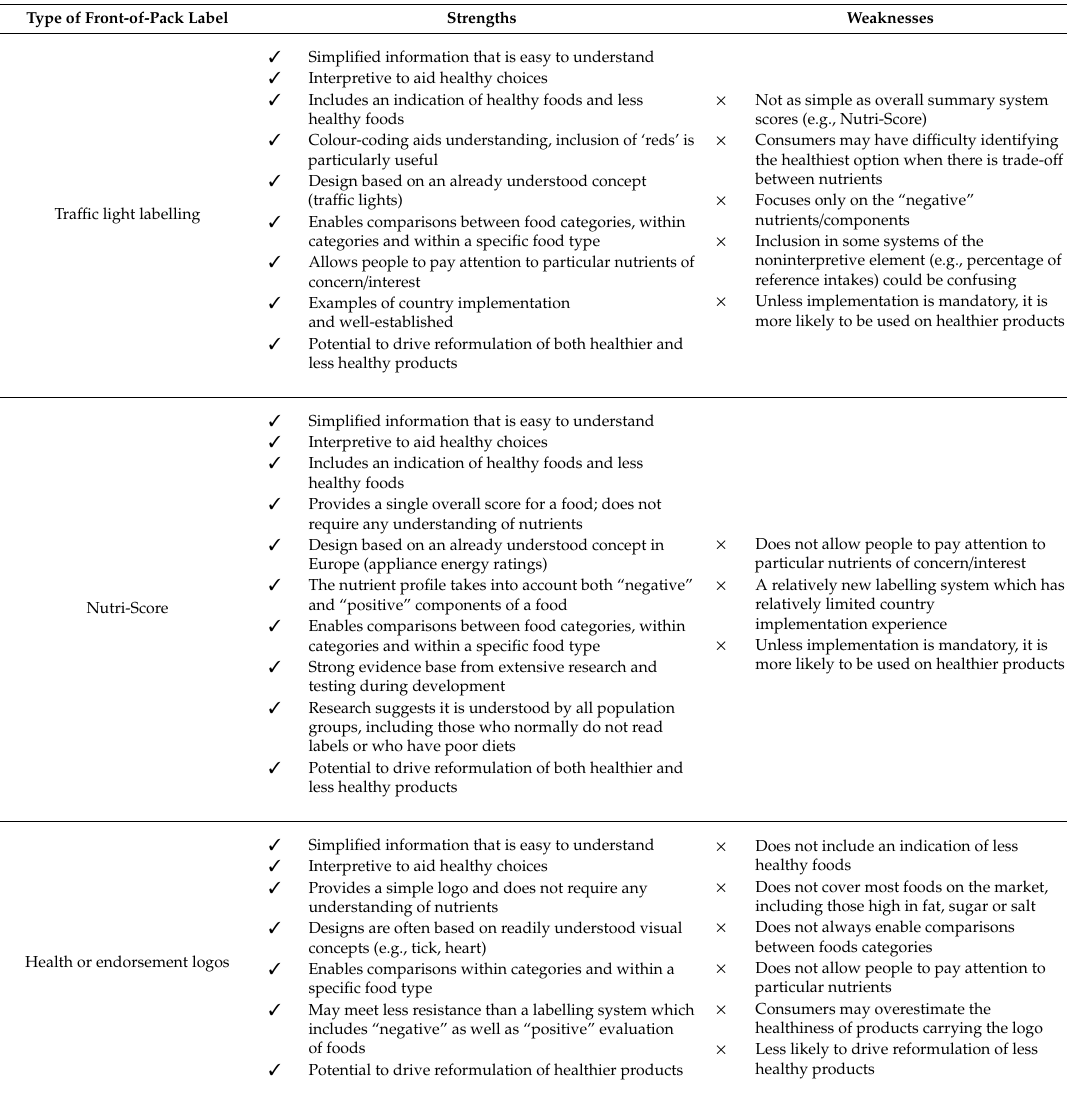
Table 3. Strengths and weaknesses of three di ff erent types of front-of-pack labels currently being adopted in the Eastern Mediterranean. Type of Front-of-Pack Label Strengths